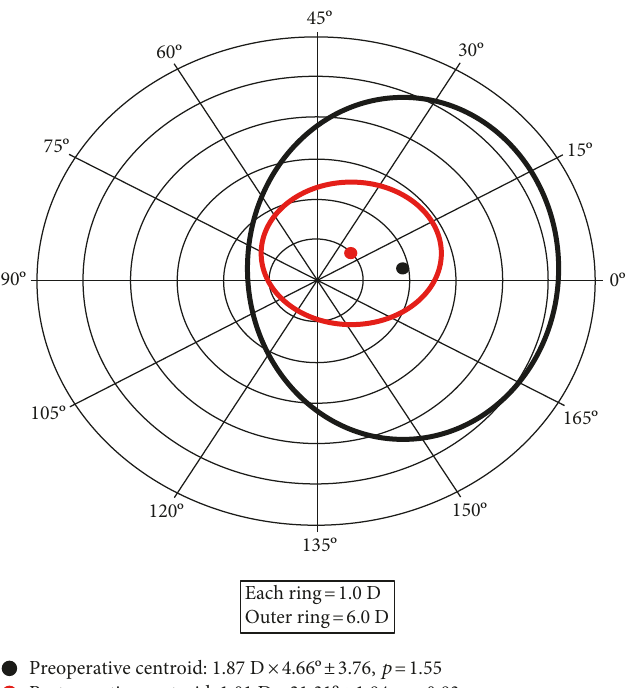
Figure 3: Double-angle plot of preoperative and postoperative refractive astigmatism. The standard deviation is represented by the area around the centroid ( p =shape factor) . Each ring=1.0D/outer